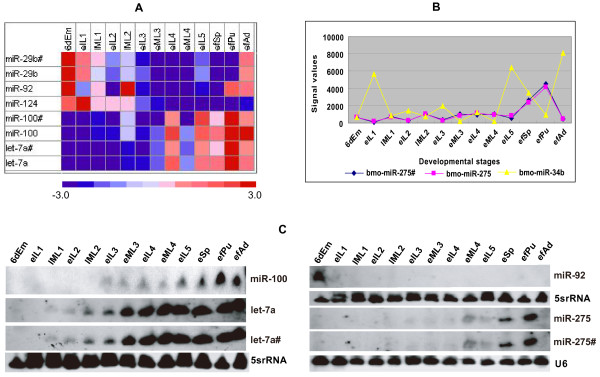
Temporal expression profile of miRNAs obtained with the whole-life test. (A) Specific miRNAs were up-regulated or down-regulated over the entire life cycle of the silkworm. (B) Comparison of the expression profiles of miR-275 and miR-34b during the life cycle of silkworm. (C) Northern blotting analysis of miRNAs during the silkworm life cycle. 5srRNA and U6 were used as the loading controls.